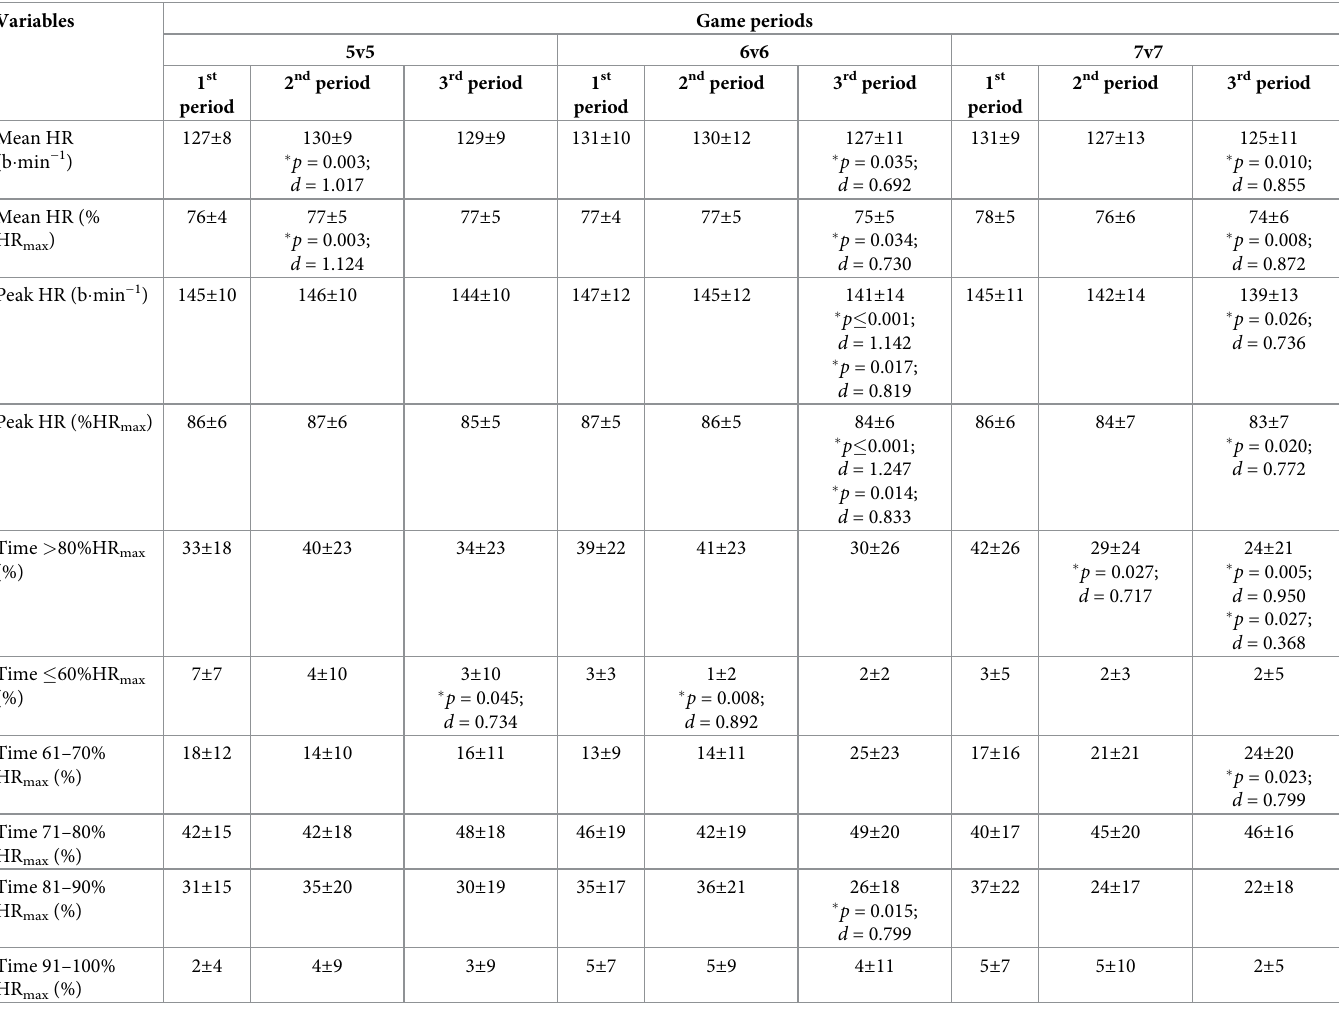
Table 4. Players’ mean, peak and percentage of total match time spent in the different heart rate zones during the three match periods in 5v5, 6v6 and 7v7 recrea- tional team handball game formats (data are presented as means ± SD).